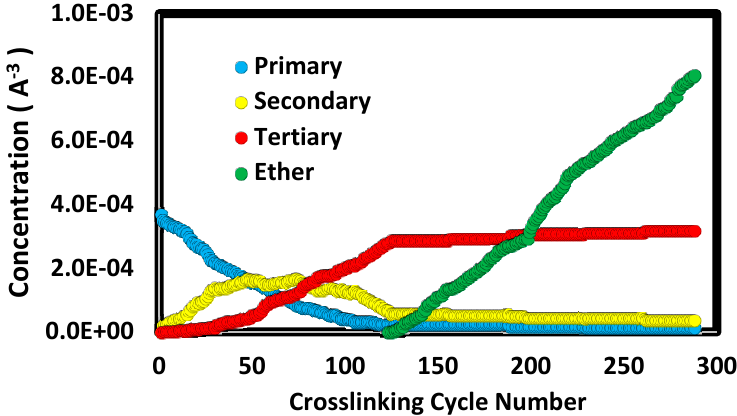
Figure 6. Amine and ether concentrations as a function of crosslink cycle number for the long-chain ( n = 1) excess epoxide system. The ether concentration is the increased over the initial uncured system.